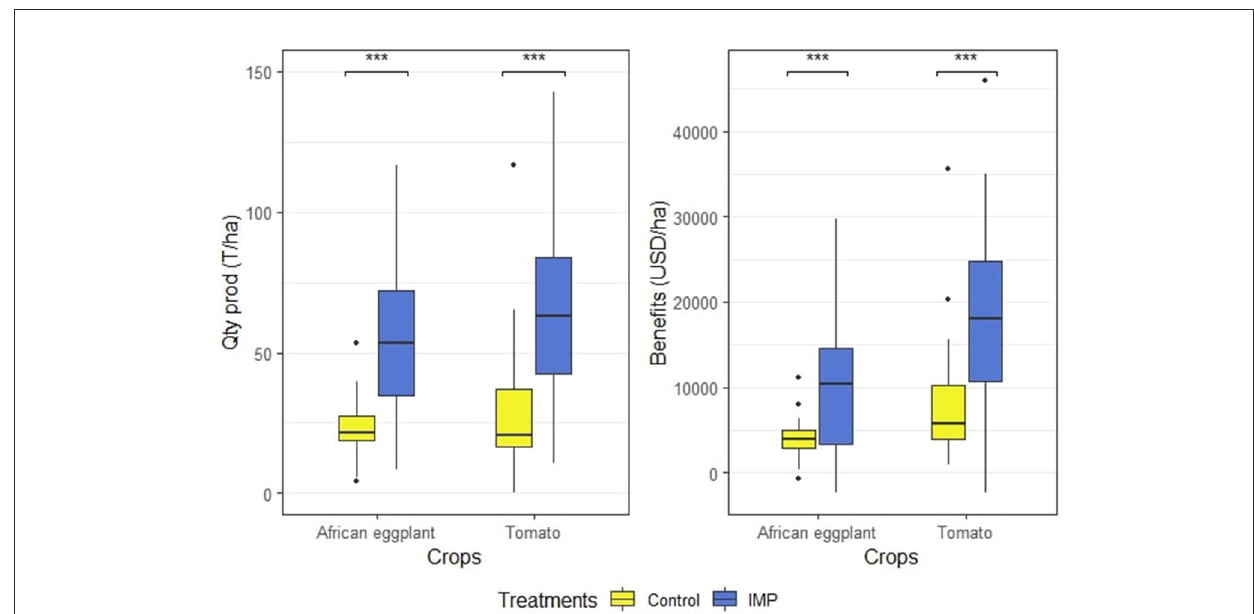
FIGURE2 The yield and net benefits (income) for African eggplant (Tengeru White) and tomato (Tengeru 10) cultivars grown under standard farmers practice (control) and integrated management practices (IMP) in the Babati district of